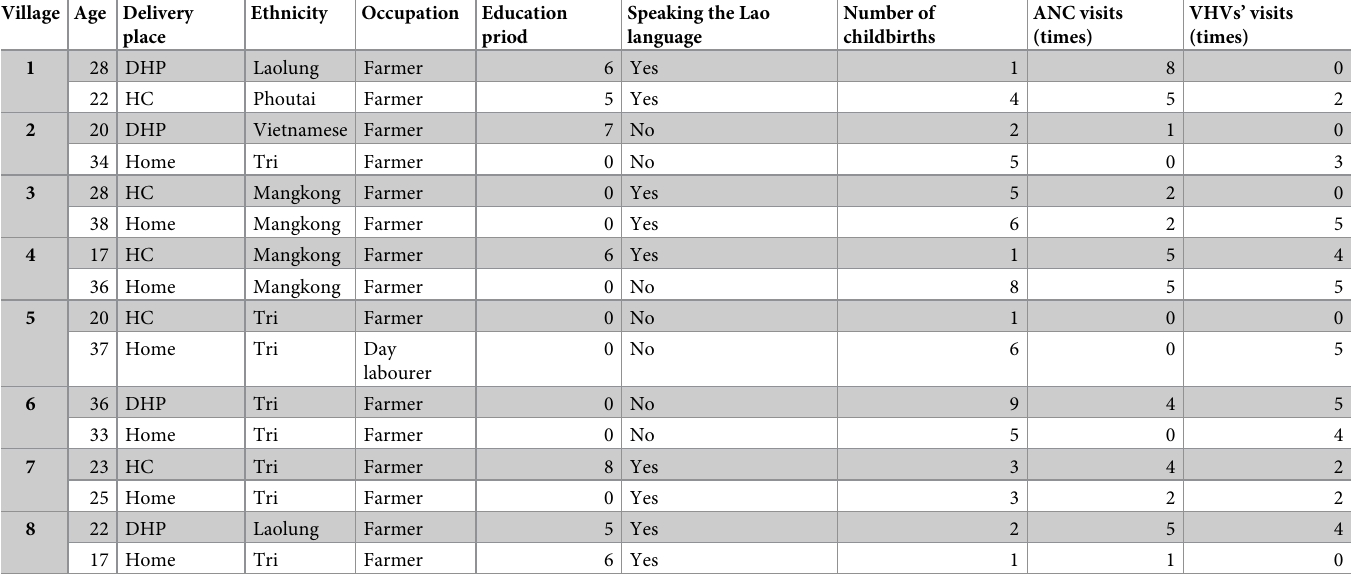
Table 2. Detailed data of the included participants.